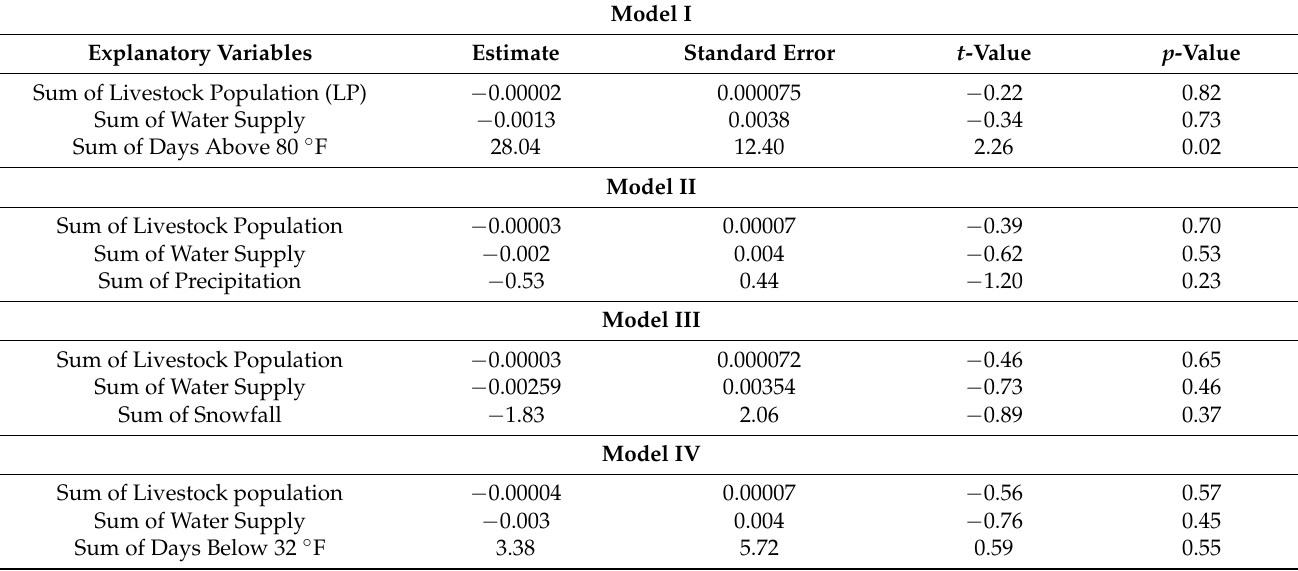
Table 3. Results of regression